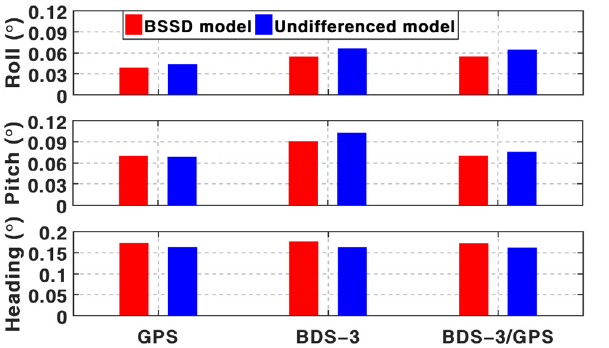
Figure 24. Mean maximum attitude drifts of different GNSS for BSSD PPP/INS/ODO TCI and undifferenced PPP/INS/ODO TCI.